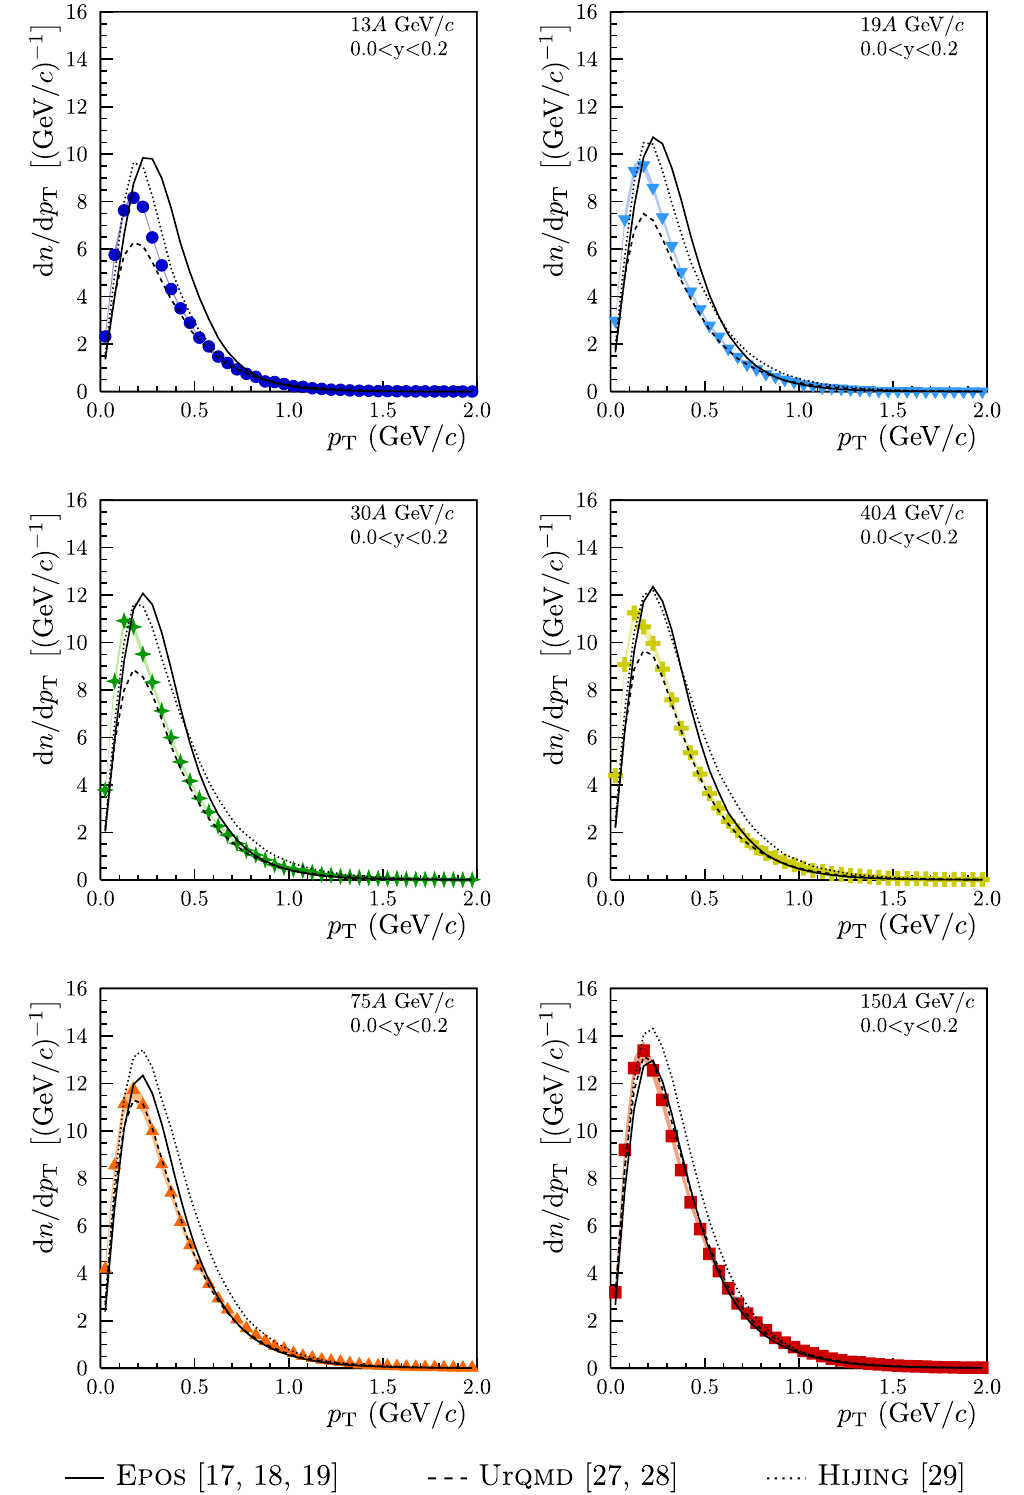
Fig. 10 Transverse momentum distributions d n / d p T at mid-rapidity for all six beam momenta. Predictions of Epos , U r qmd and Hijing models are shown by curves of different line styles. Statistical uncertainties are smaller than the marker size and systematic uncertainties are indicated by shaded